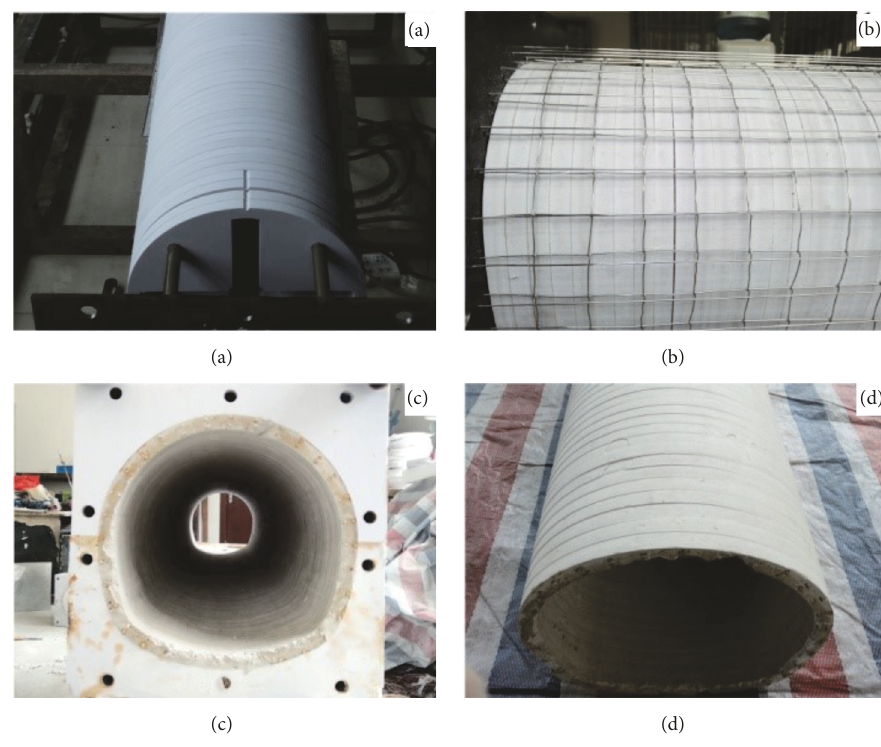
Figure 4: The manufacturing procedure of model tunnel.